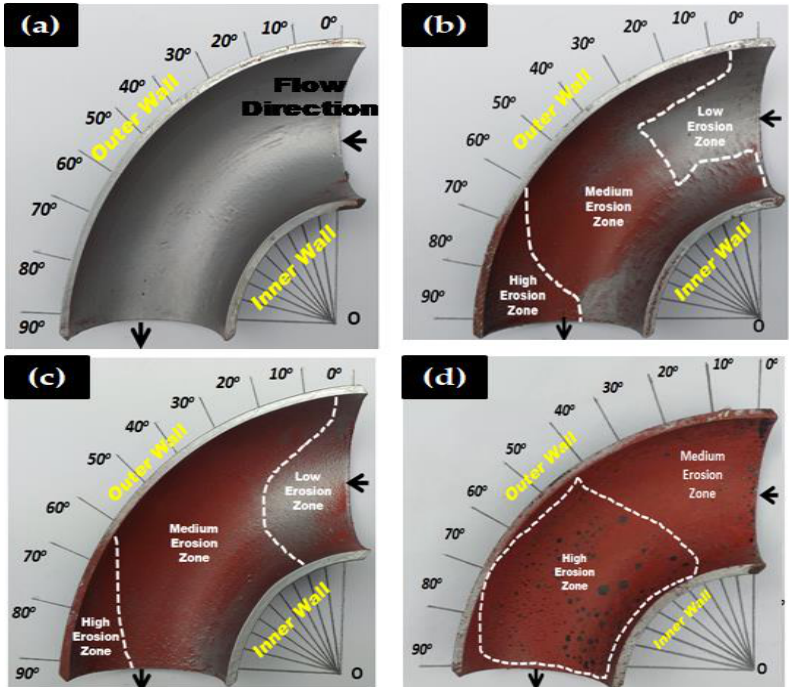
Figure 7. Paint erosion pattern for slug flow with V s L = 0.5 m/s and V s G = 2.5 m/s in a 90° horizontal-horizontal elbow upper section. ( a ) Without sand [8], ( b ) 2 wt.% sand fines [8], ( c ) 5 wt.% sand fines [36], and ( d ) 10 wt.% sand fines.